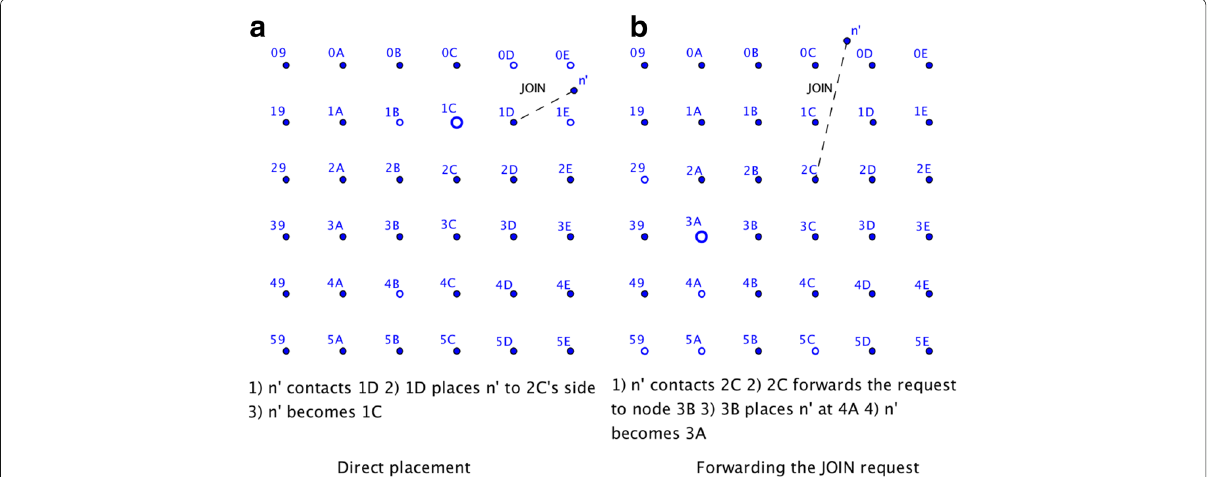
Fig. 5 Two cases of node n (cid:10) joining the system. a Direct placement: n (cid:10) will be placed by 1D based on a greedy manner at position 1C. b Forwarding the join request: 2C does not have an empty spot. The join request will be sent to node 3B which will place n (cid:10) at